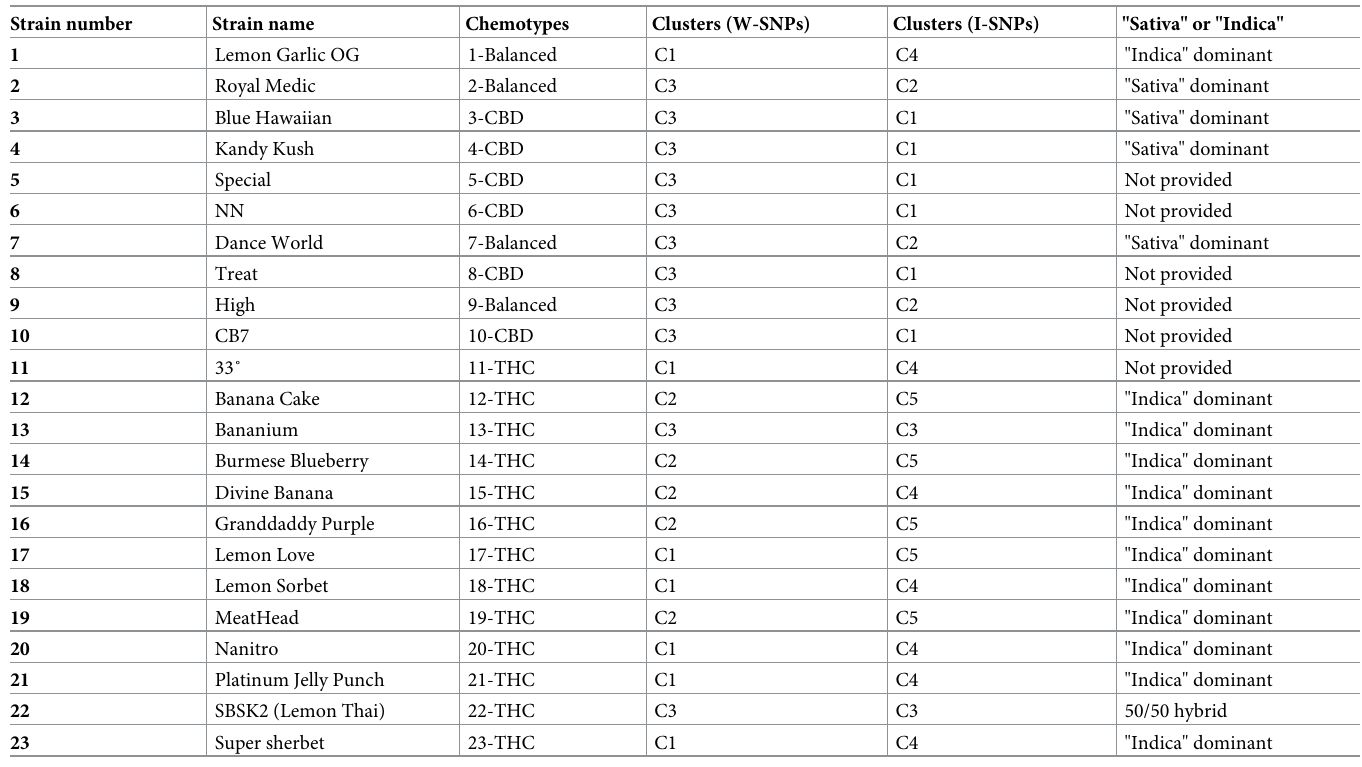
Table 1. Strain information of 23 strains and preassigned clusters by